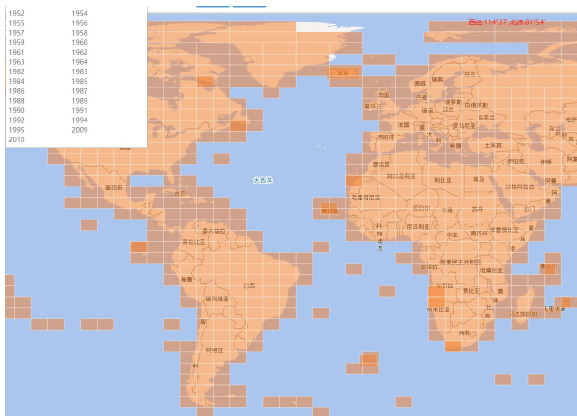
Figure 4 . Time-space dimension map coverage diagram.